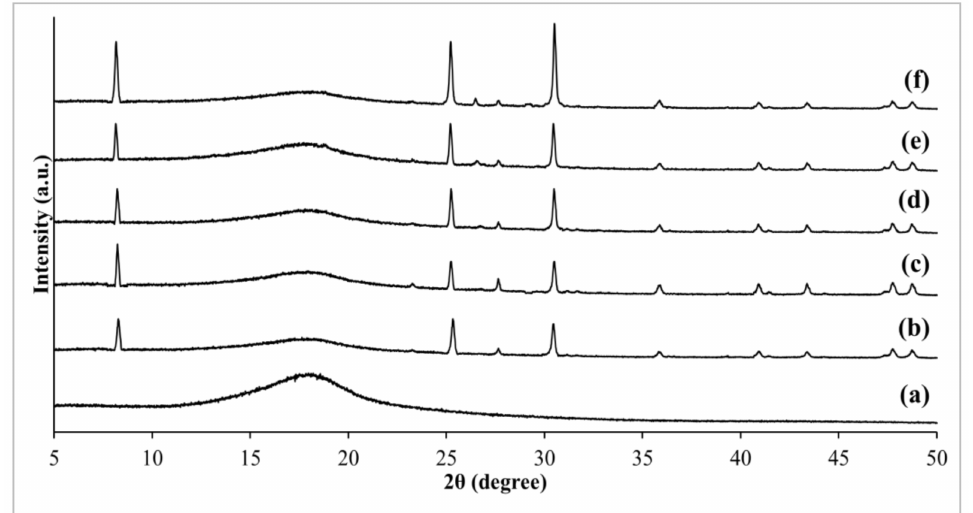
Figure 4. XRD patterns of (a) pristine PSf membrane, (b) 1NH 2 -RHO/PSf, (c) 2NH 2 -RHO/PSf, (d) 3NH 2 -RHO/PSf, (e) 4NH 2 -RHO/PSf, and (f) 5NH 2 -RHO/PSf